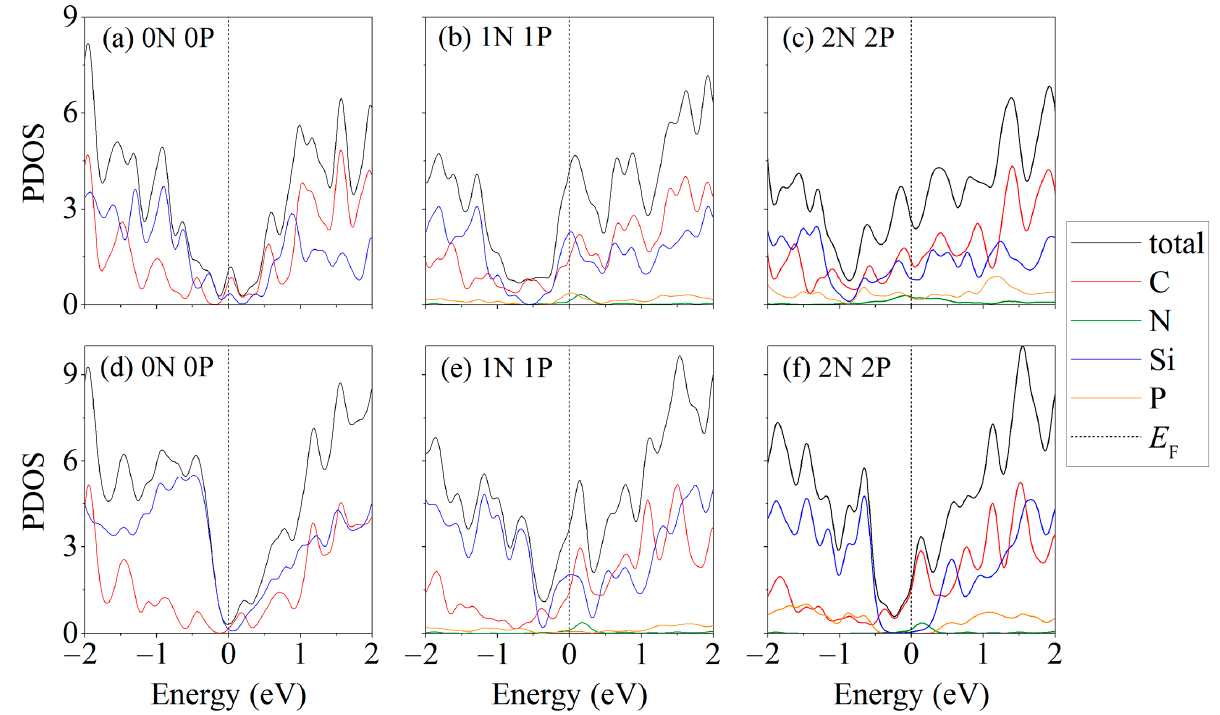
Figure 6. Partial densities of electronic states of doped monolayer ( a – c ) and bilayer ( d – f ) sili- cene/graphite substrate systems.